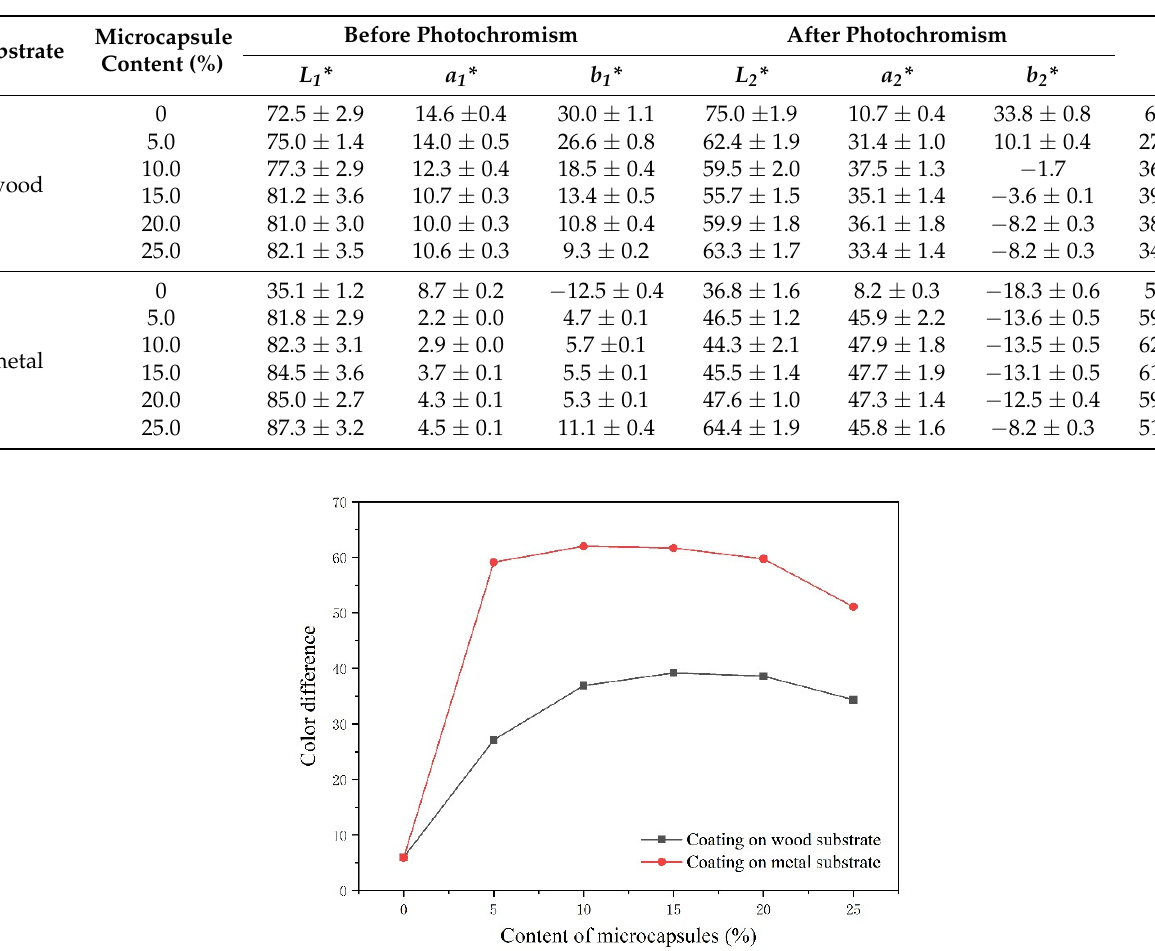
Figure 8. Discoloration process of the coating on the wood substrate with 15.0% microcapsules. Vis- ible light exposure time: ( A ) 0 s, ( B ) 5 s, ( C ) 10 s, ( D ) 15 s, ( E ) 20 s. Figure 9. Discoloration process of the coating on the metal substrate with 10.0% microcapsules. Vis- ible light exposure time: ( A ) 0 s, ( B ) 5 s, ( C ) 10 s, ( D ) 15 s, ( E ) 20 s. Figures 10 and 11 show the SEM images of coatings with the addition of different contents of microcapsules on wood and metal substrates. They show that the coating sur- face without microcapsules is smooth. When the microcapsule content increased to 15.0% and 20.0%, the particles on the coating surface gradually increased. Due to the small par- ticle size of microcapsules and the small content of microcapsules, the microcapsules can still be slightly uniformly dispersed in the coating. Therefore, the surface of the prepared coatings is relatively smooth.